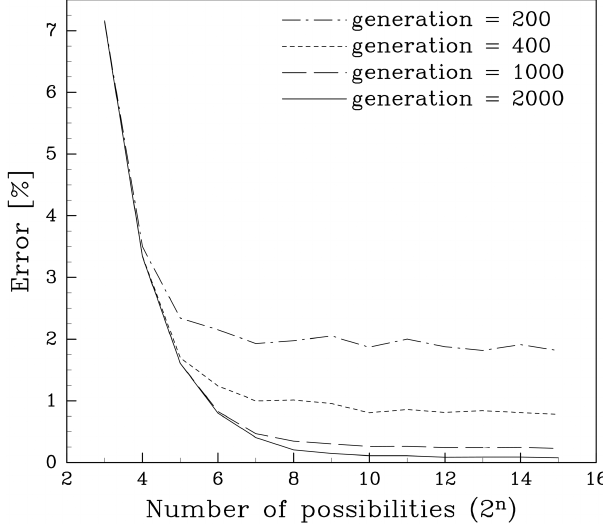
Fig. B1. An expected error of the estimated parameters by the